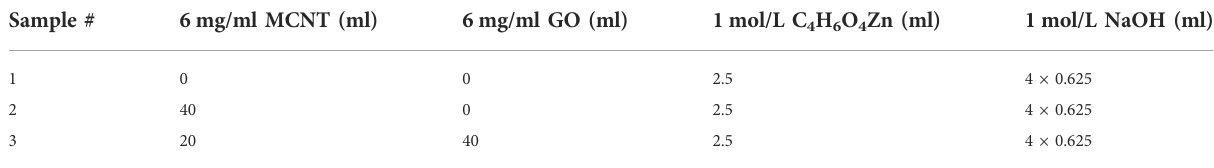
TABLE 2 The raw material ratio of